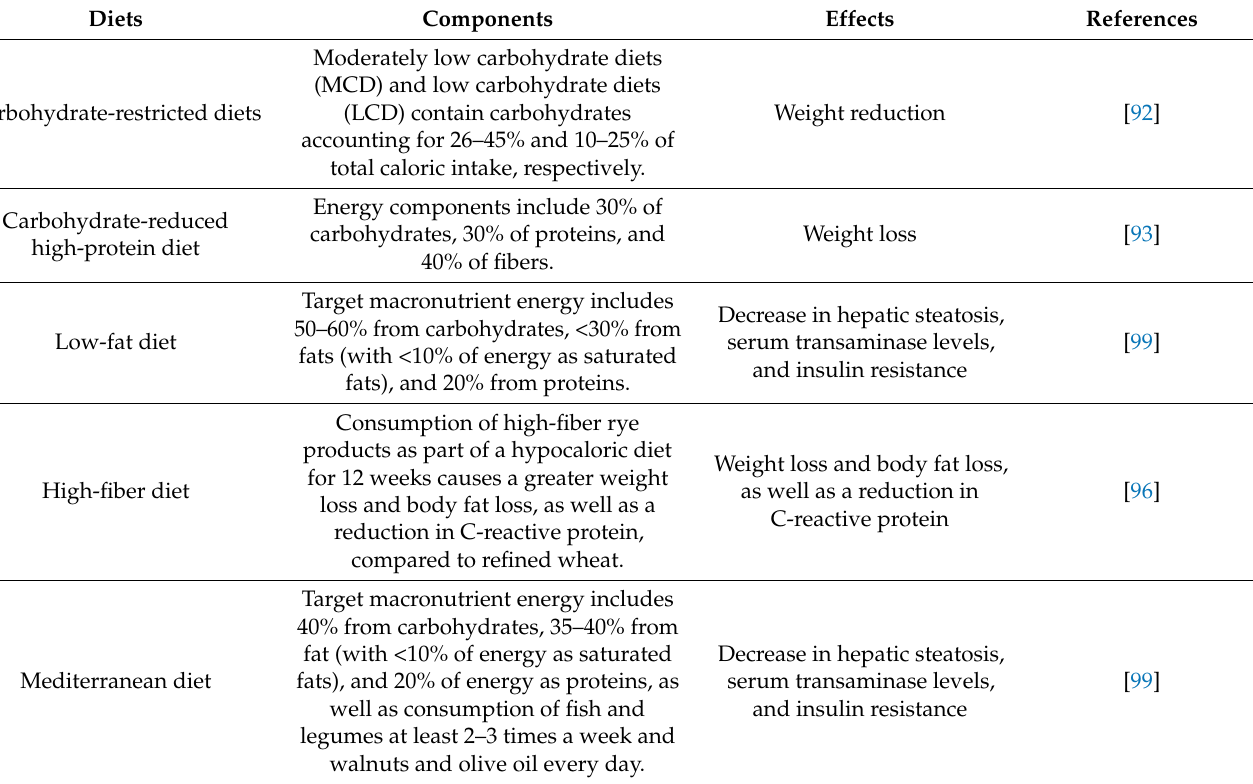
Table 1. Dietary components and their effects on